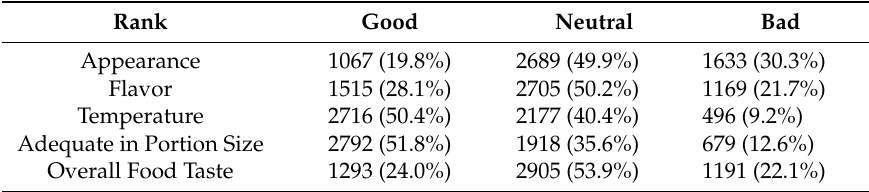
Table 5. Students’ opinion on school lunches/ n